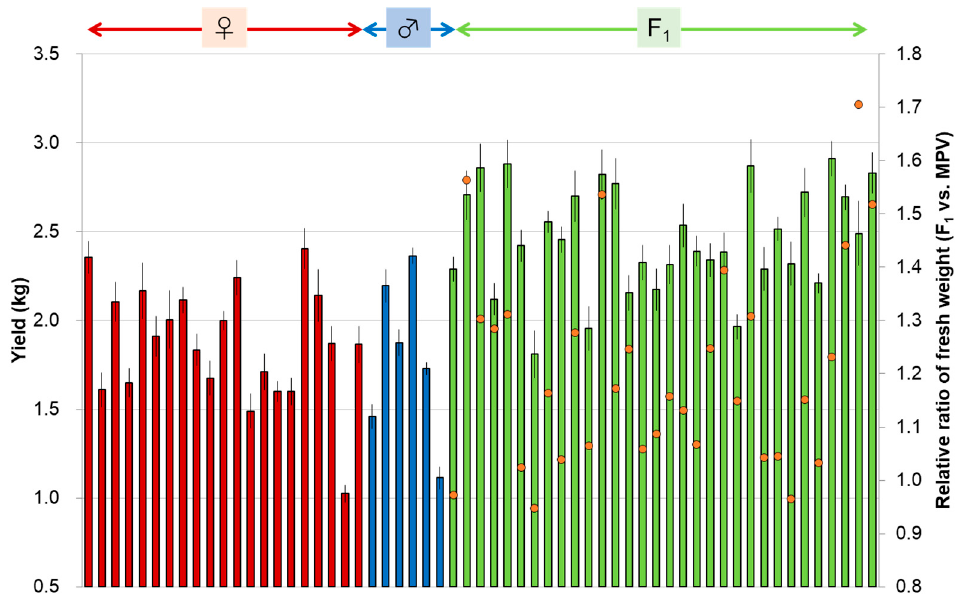
Figure 3. Increased plant size in F 1 (W39) compared with parental lines (S27 female inbred and R29 male inbred line) at 18 days after sowing in Chinese cabbage. The data are from [39].